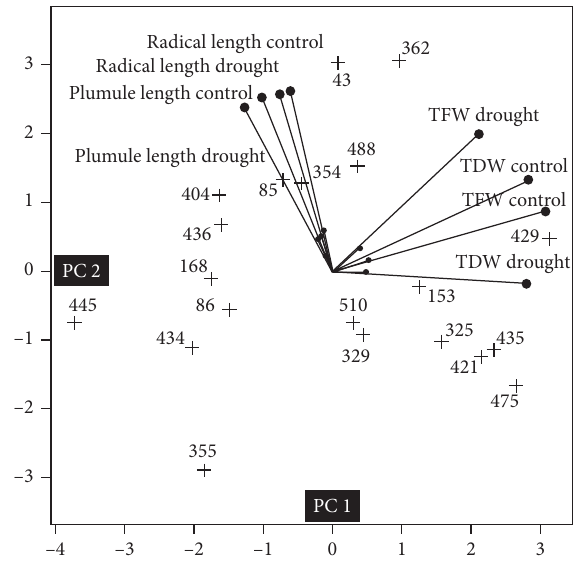
Figure 2: Biplot analysis for the gain in radical and plumule length and radical and plumule total fresh weight (TFW) and total dry weight (TDW) under control and drought environments.